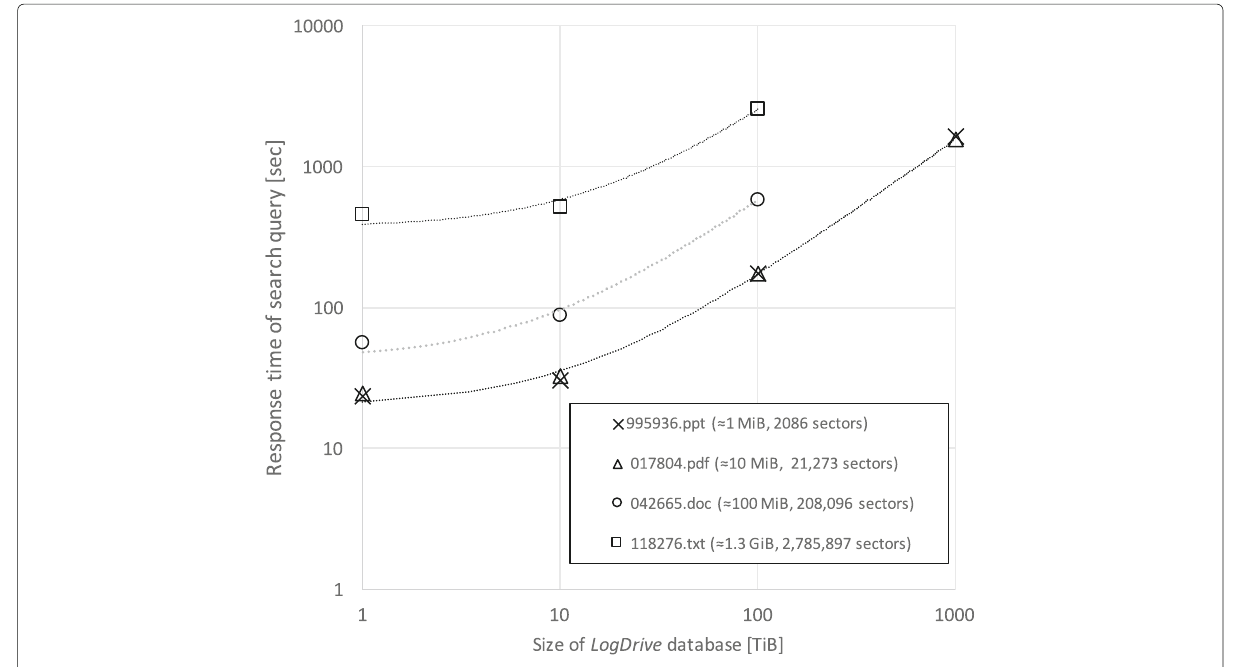
Fig. 12 Response time of search query (Algorithm 4 with random